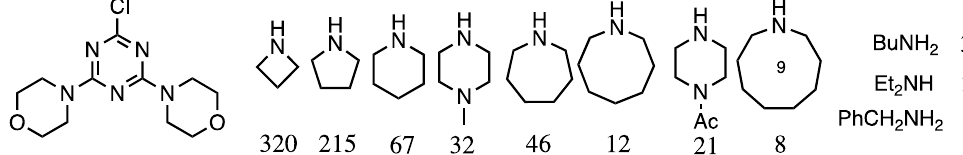
Figure 1. Relative reactivity of amines for a monochlorotriazine. The values for reaction with the monochlorotriazine shown are normalized to benzylamine.